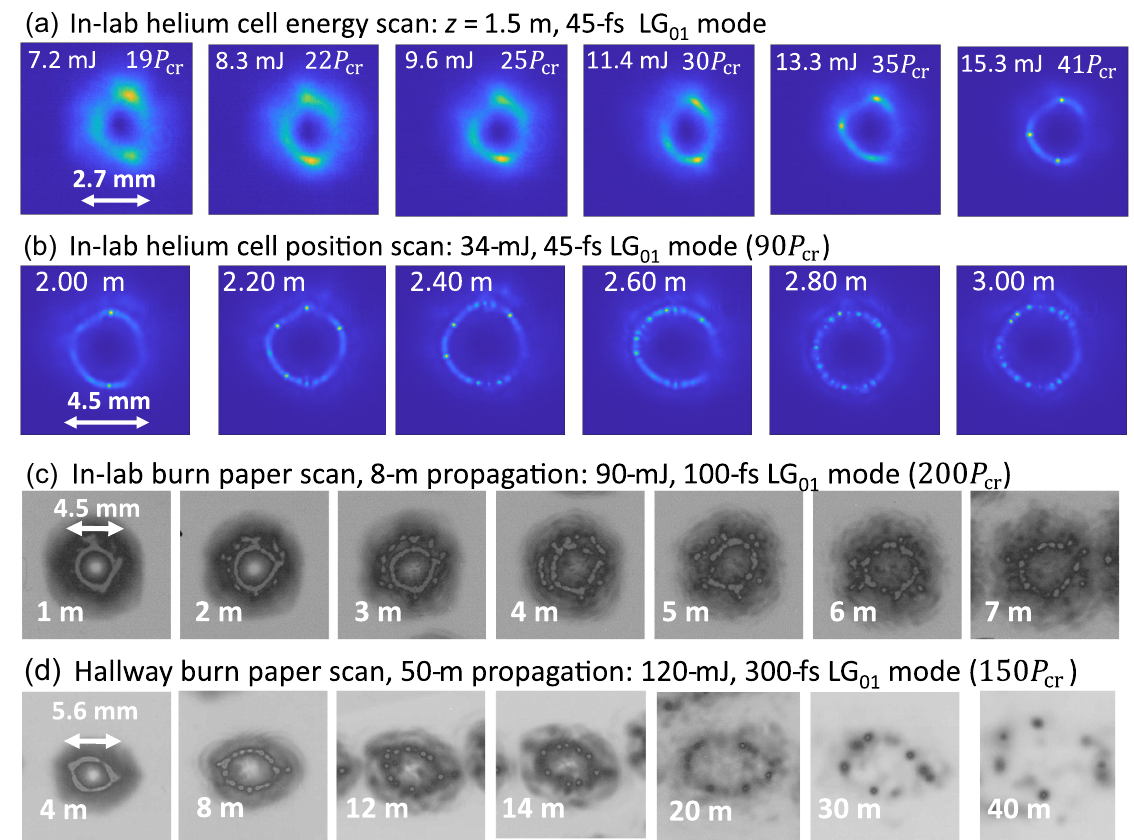
FIG. 4. (a) Mode images from helium cell of pulse-energy scan showing progressive narrowing of the LG 01 ring and nucleation of filaments. The peak pulse power in units of P is shown in each image. (b) In-lab images from longitudinal scan of the helium cell for a cr LG 01 pulse with P ¼ 90 P , showing nucleation of filaments and their progressive increase in number. (c) In-lab burn paper patterns cr taken for comparison with helium cell images. (d) Hallway burn patterns over the length of propagation